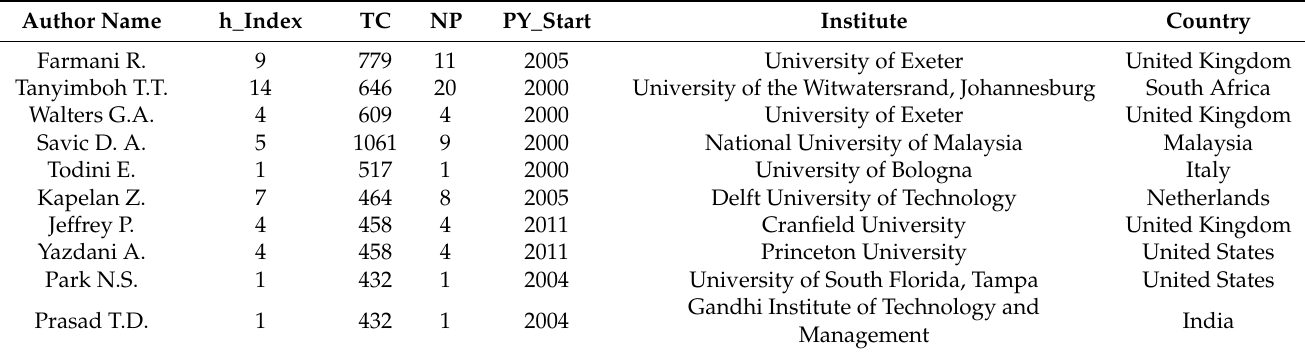
Table 2. Top ten most influential authors ranked by total number of